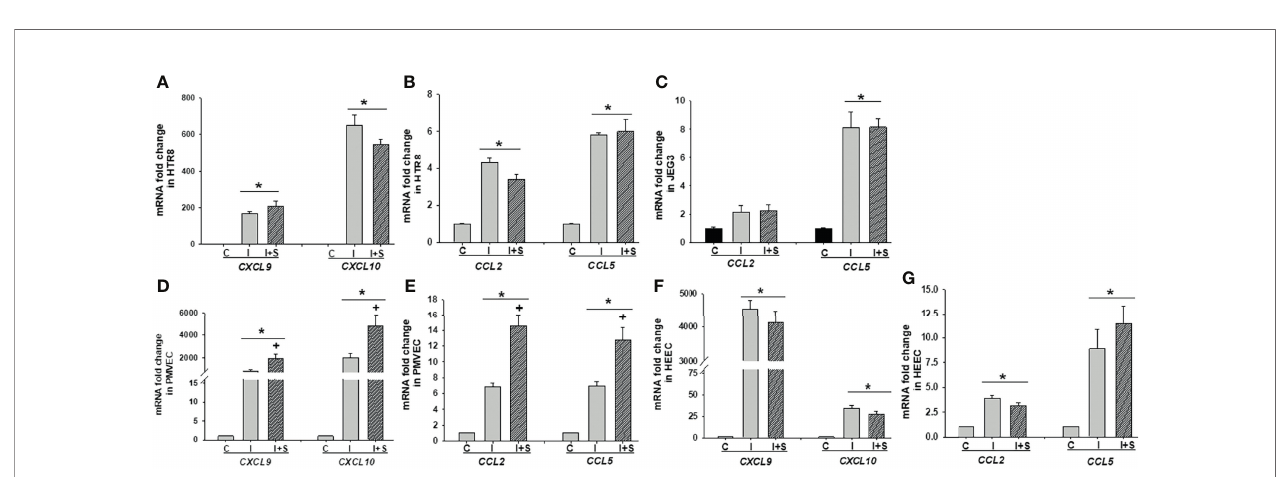
FIGURE 6 | Recombinant IFN g with or without S-protein signi fi cantly increases mRNA levels of chemokines in trophoblastic and endothelial cell cultures. Expression of chemokines CXCL9 , CXCL10 (A) ; CCL2 and CCL5 (B) in HTR8/SV neo , expression of chemokines CCL2 and CCL5 (C) in JEG3 ; expression of chemokines CXCL9 , CXCL10 (D) , CCL2 and CCL5 (E) in PMVECs; expression of chemokines CXCL9 , CXCL10 (F) , CCL2 and CCL5 (G) in HEECs treated with either control or 10 ng/ml rh-IFN g ± 10 ng/ml rh-S-protein treated cells. Bars represent mean ± SEM, n=3; * P<0.05 vs . control. + P<0.05 vs . IFN g alone. C, Control; I, rh-IFN g ; and I+S, rh-IFN g +